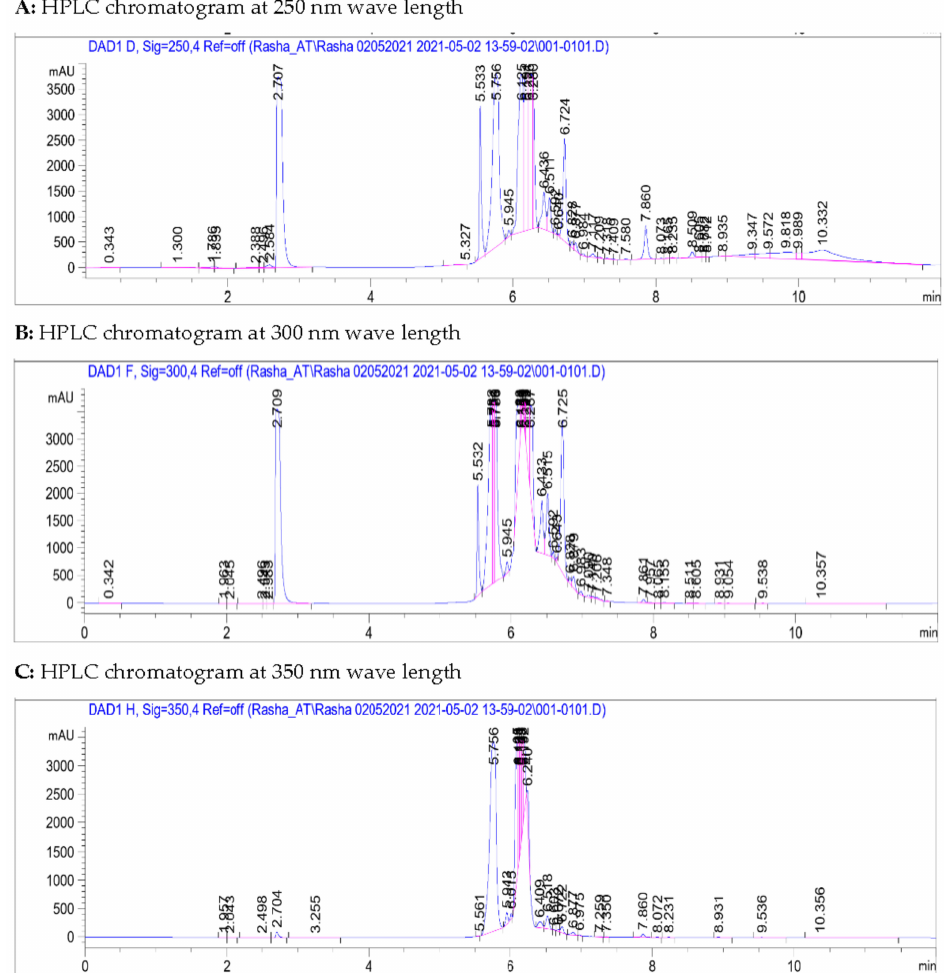
Figure 2. HPLC Chromatograms of the Aloe perryi Resins Methanolic Extract at Different Wavelengths ( A – C ). It is demonstrated from the first chart at wave length 250 nm ( A ), that there is a single peak eluted at 2.7 min retention time, followed by a bundle of around nine (9) peaks eluted in the area of 5.5 to 7.8 min retention time. The second wave length at 300 nm ( B ) showed almost the similar elution, with one peak that not eluted at 7.8 min in the area of non-polar compounds. Lastly, there is only a group of a non-polar compounds appears within the retention time of 5.5–6.4 min retention time at wave length 350 ( C ). It could be concluded that 250 nm represent the best elution and separations for the peaks. nm: nanometers; mAU: milli Absorbance Unit; Em: emission; Ex: